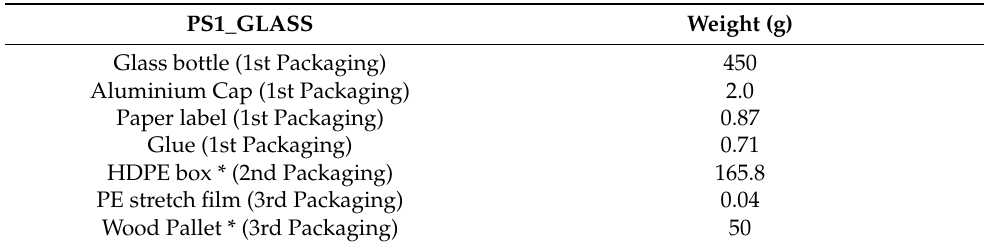
Table 1. Weight and composition of all the components of the PS1_GLASS system (the values are the same for both natural and sparkling water).